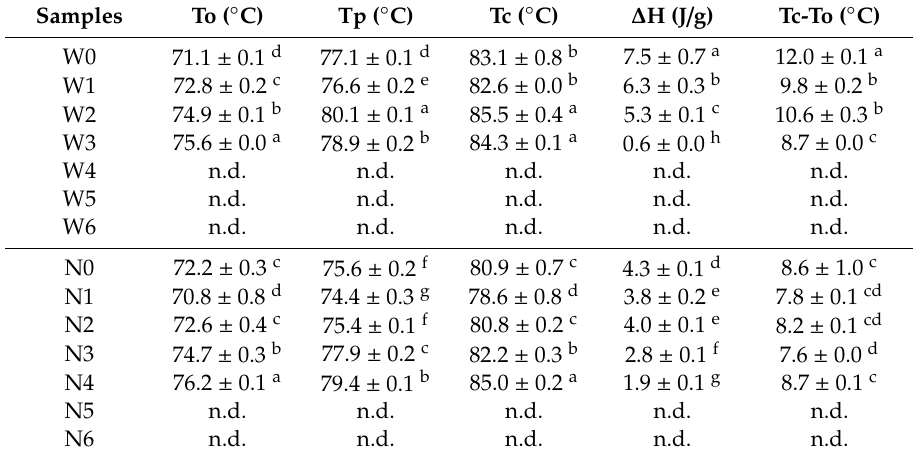
Table 2. Thermal properties of uncooked and cooked flours.